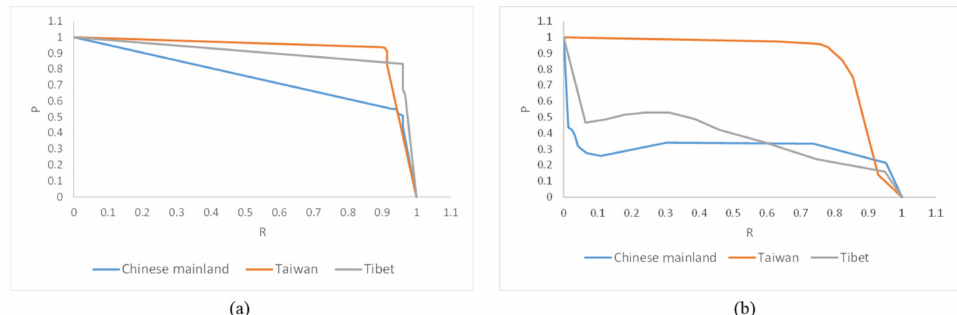
Figure 6. P–R curves of two categories of models: ( a ) single-target cascading model; ( b ) multi- target model.